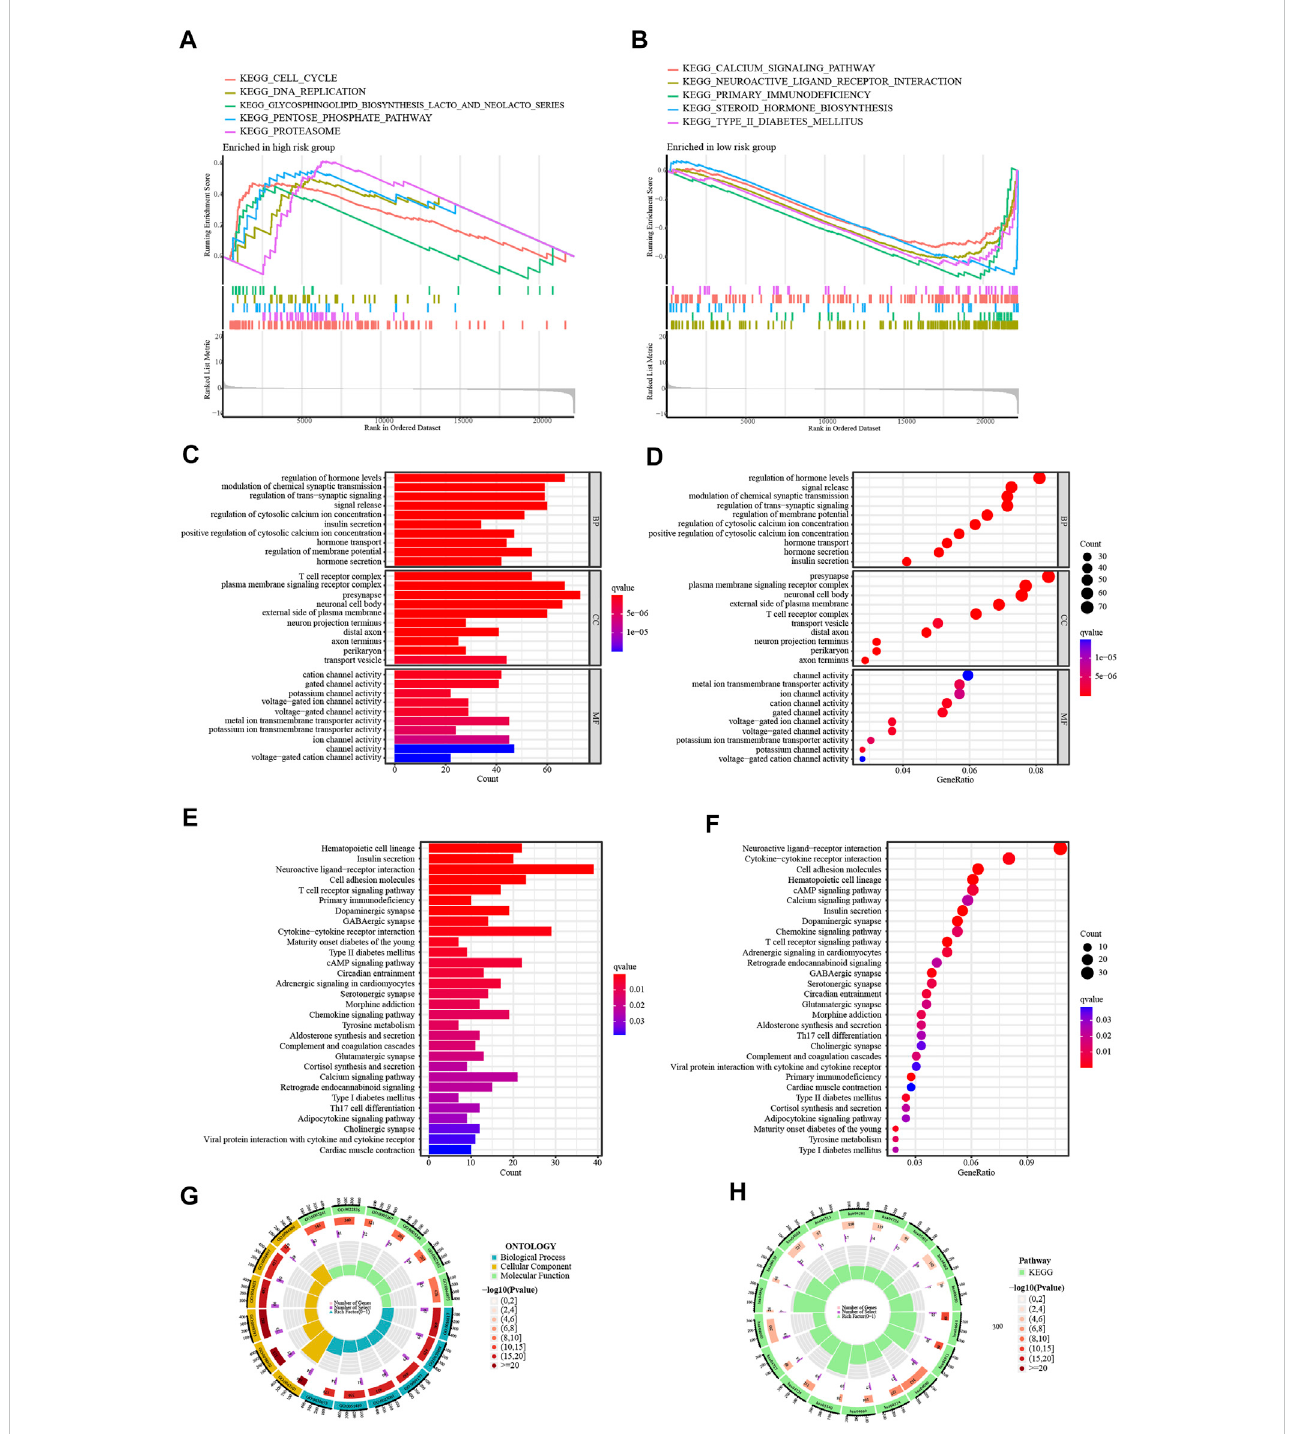
FIGURE 7 Enrichment Analysis of GSEA. (A,B) GSEA of thetop 5 up-regulated and down-regulated KEGG signaling pathwaysenriched in high and low-risk groups. Enrichment Analysis of risk differentially expressed genes. (C,D) The bar and bubble plots of GO terms. (E,F) The bar and bubble charts of KEGG terms. (G,H) The GO and KEGG enrichment circle